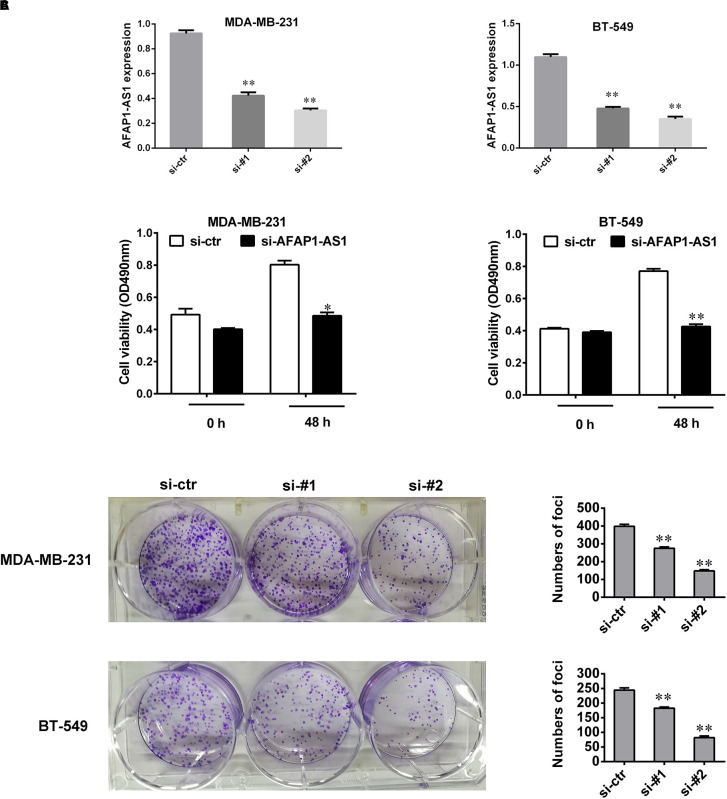
AFAP1-AS1 knockdown suppressed cell proliferation and colony formation in TNBC cells. (A) siRNA knockdown efficiency of AFAP1-AS1 expression in MDA-MB-231 and BT-549 cells by qRT-PCR (∗∗P < 0.01). (B) MTT assay on the cell viability of MDA-MB-231 and BT-549 cells infected with siRNA-AFAP1-AS1, or siRNA-ctr (∗P < 0.05 and ∗∗P < 0.01). (C) Colony formation assays on MDA-MB-231 and BT-549 cells transfected with siRNA-ctr, siRNA-#1, or siRNA-#2 (∗∗P < 0.01). The representative data from three independent experiments are shown.